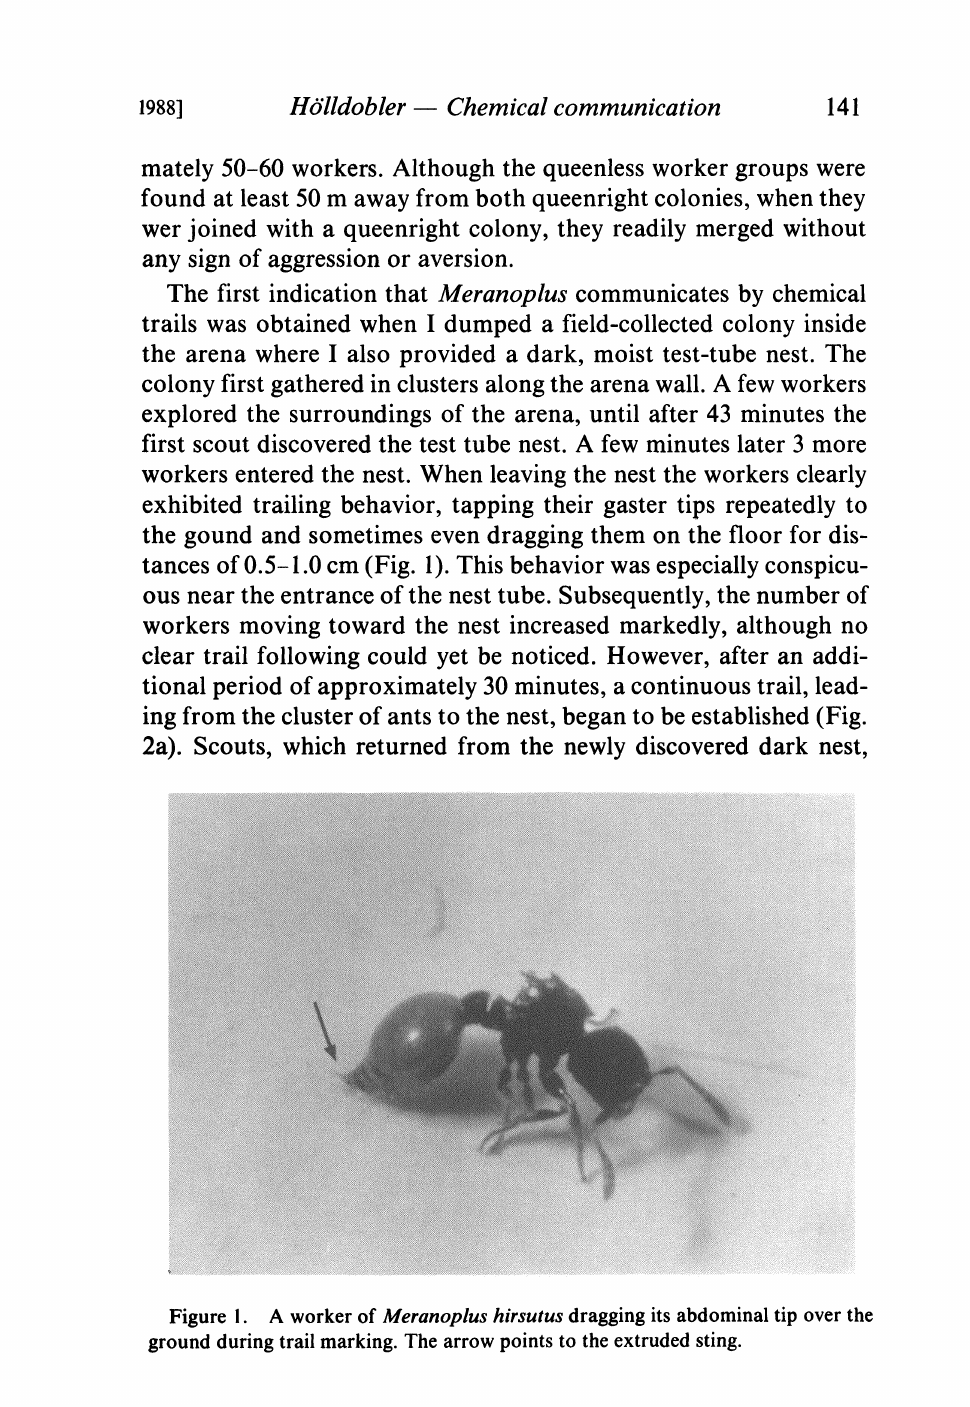
Figure I. A worker of Meranoplus hirsutus dragging its abdominal tip over the ground during trail marking. The arrow points to the extruded